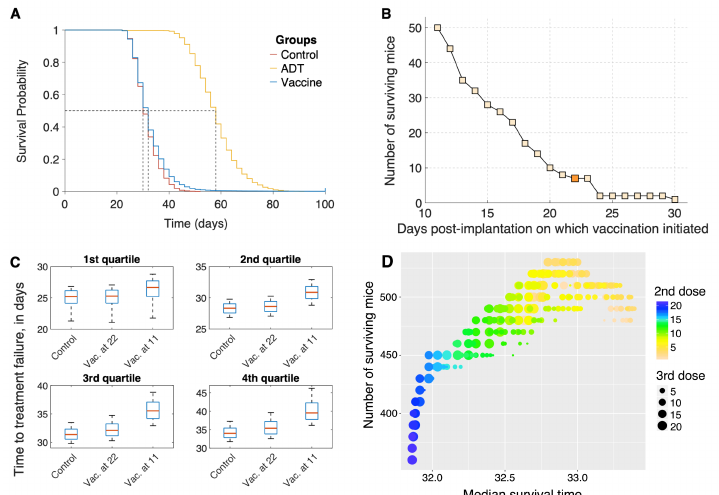
Figure 4. ( A ) Overall survival of simulated mice from time of therapy initiation. ( B ) Predicted number of mice that are alive at the end of the in silico trial (100 days), as a function of time post-xenograft implantation when first dose of sipuleucel-T was administered. Three total doses of vaccine were administered, given weekly. Dark shaded square corresponds to blue survival curve shown in panel ( A ). ( C ) Box plots of time to treatment failure (inter-quartile range and median) for the same simulated mice untreated (control), or recieving vaccination starting at either 22 or 11 days. Each subpanel corresponds to independent quartiles of the three strategies. ( D ) Optimization of sipuleucel-T scheduling. 3 total doses of vaccine were administered, with time of treatment initiation fixed at day 11 post-xenograft implantation, and times between second and third doses allowed to